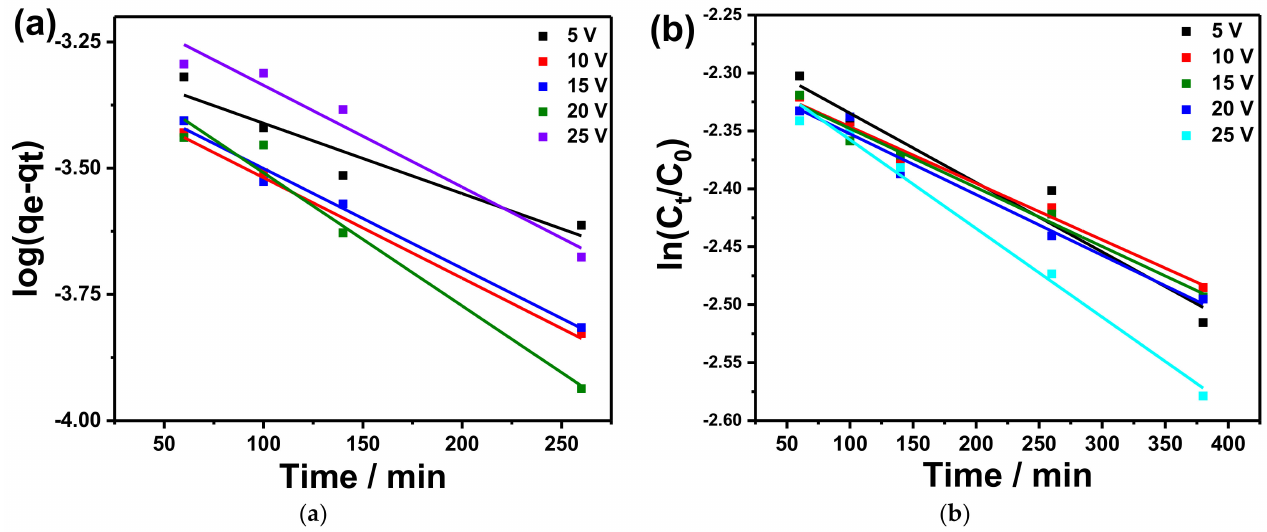
Figure 6. ( a ) Pseudo-first-order kinetic model for adsorption of methylene blue (MB) using anodized copper foam in 0.1 M K 2 CO 3 at 5, 10, 15, 20, 25, and 25 V as a catalyst; ( b ) the linear relation of ln ( C / C o ) versus the illumination time of MB in the presence of various anodized copper foam in 0.1 M K 2 CO 3 at 5, 10, 15, 20, 25, and 25 V as a catalyst. Table 2. Pseudo-first-order, pseudo-second-order parameters, and experimental q e and parameter values of the intra-particle diffusion model for the adsorption of methylene blue using anodized copper foam in 0.1 M K 2 CO 3 at 5, 10, 15, 20, 25, and 25 V as a catalyst. Anodizing Voltage Parameter